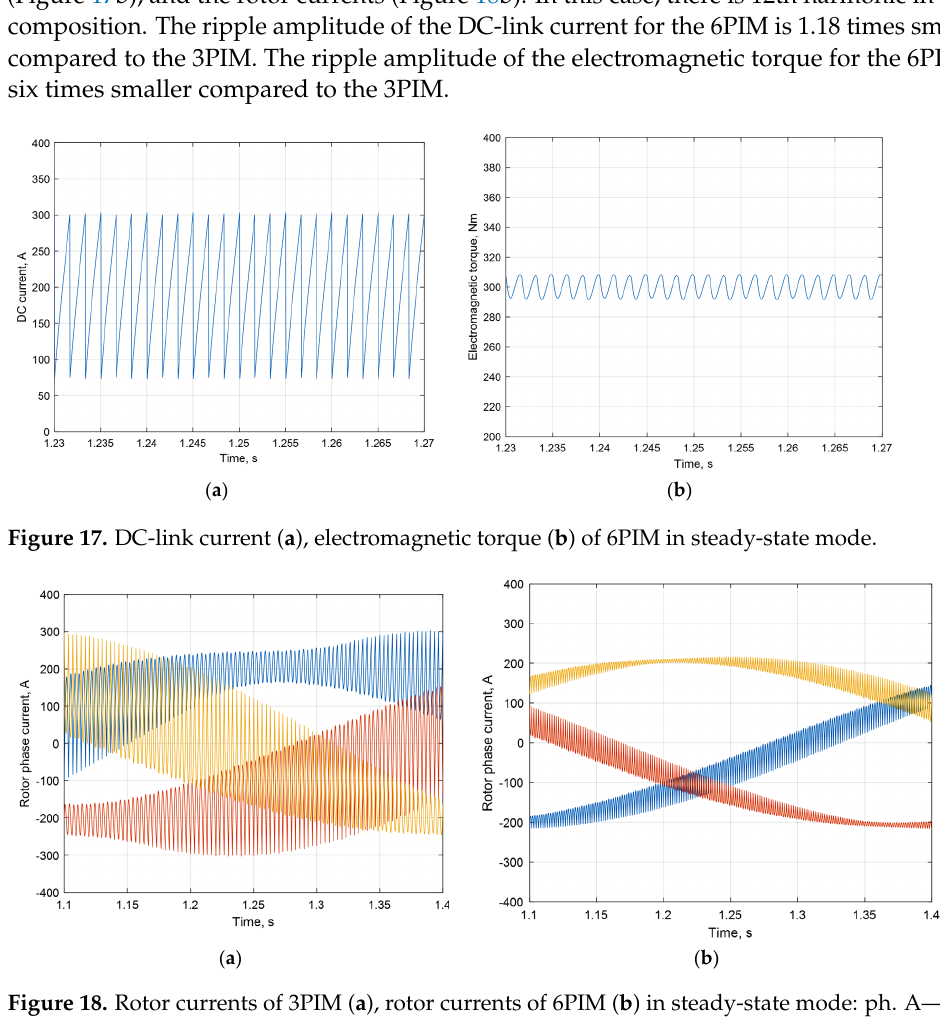
π π =α provides the sixth =α provides the sixth 6 6